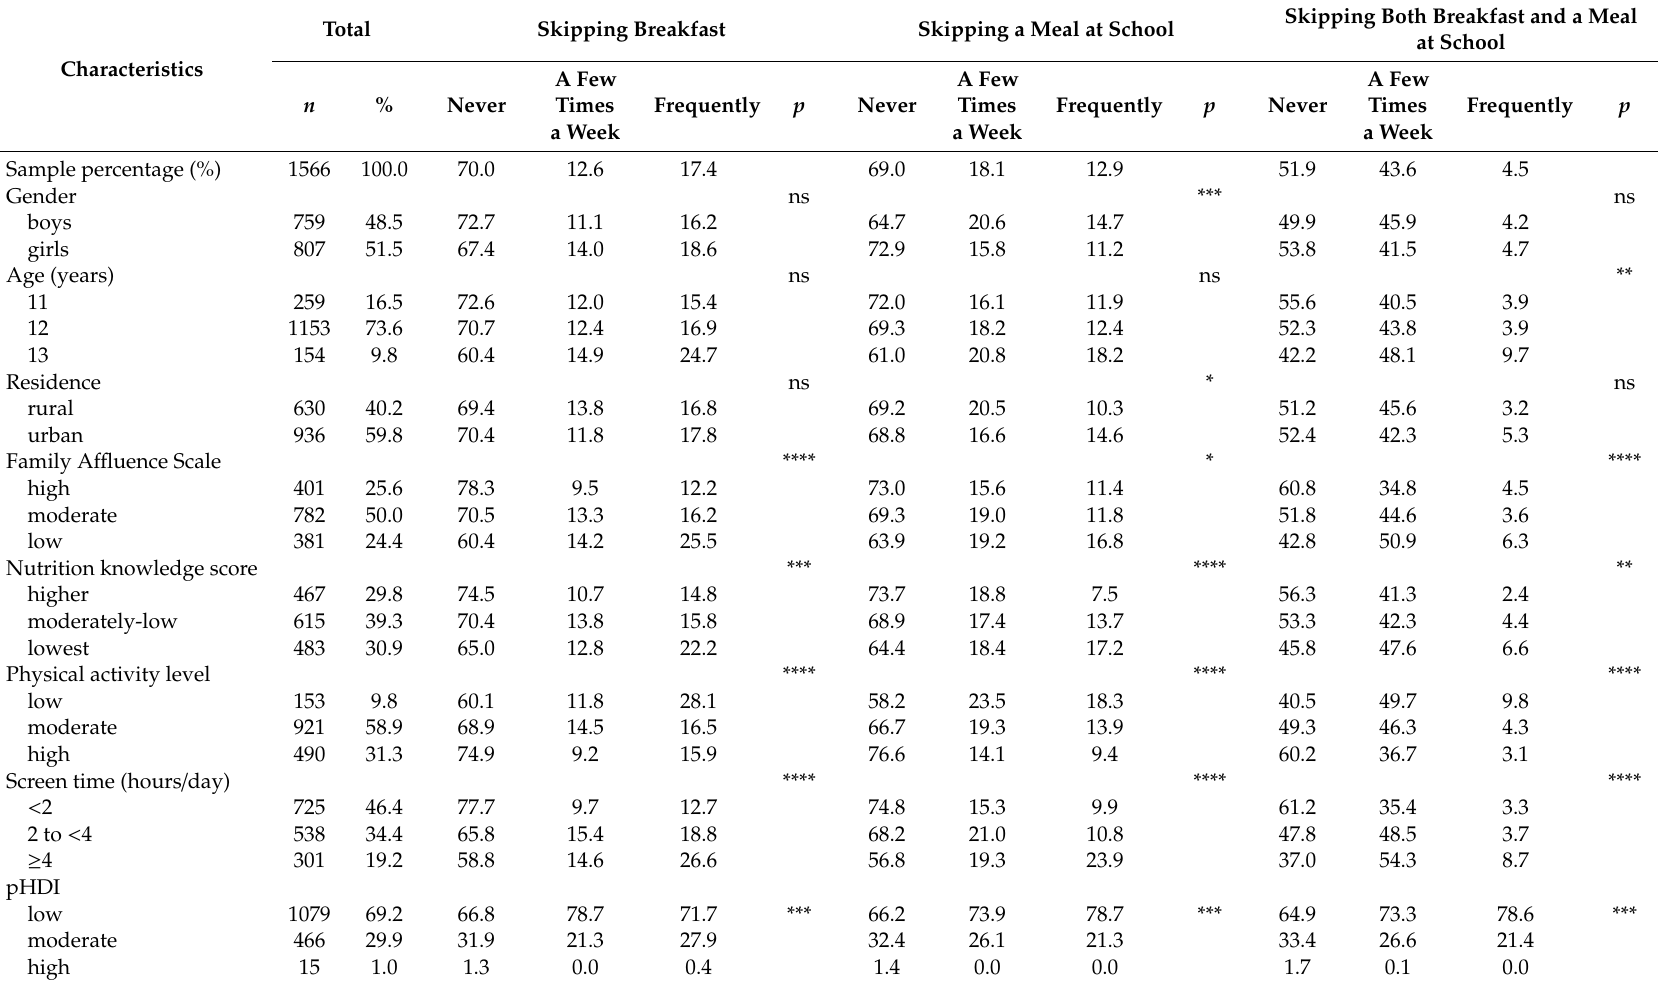
Table 3. Distribution of subjects skipping breakfast and / or a meal at school, socioeconomic correlates, nutrition knowledge, and lifestyle. (Number of subjects and percentages summing up to 100% in rows or